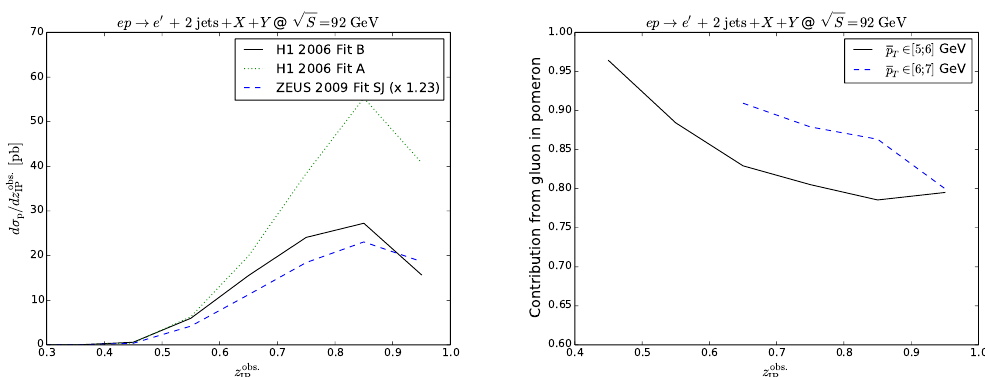
Figure 2: Left: Distributions in the observed pomeron momentum fraction z obs. three different sets of diffractive PDFs at NLO QCD. Right: Evolution in Q 2 ∼ ¯ p 2